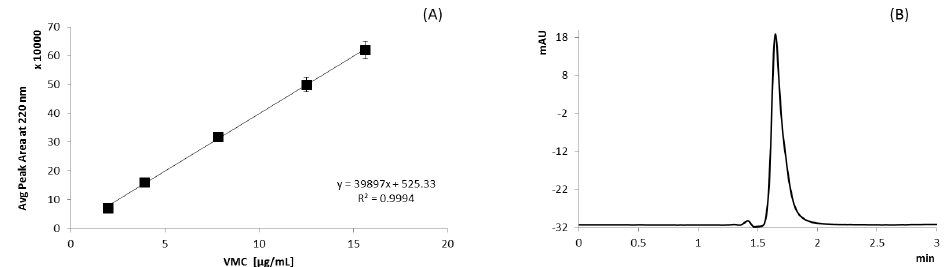
Figure 1. Calibration curve of VMC solutions of different concentrations (1.95–15.63 µg/mL) meas- ured at 220 nm ( A ), HPLC chromatogram of VMC standard solution in DI water (0.5 µg/mL) ( B